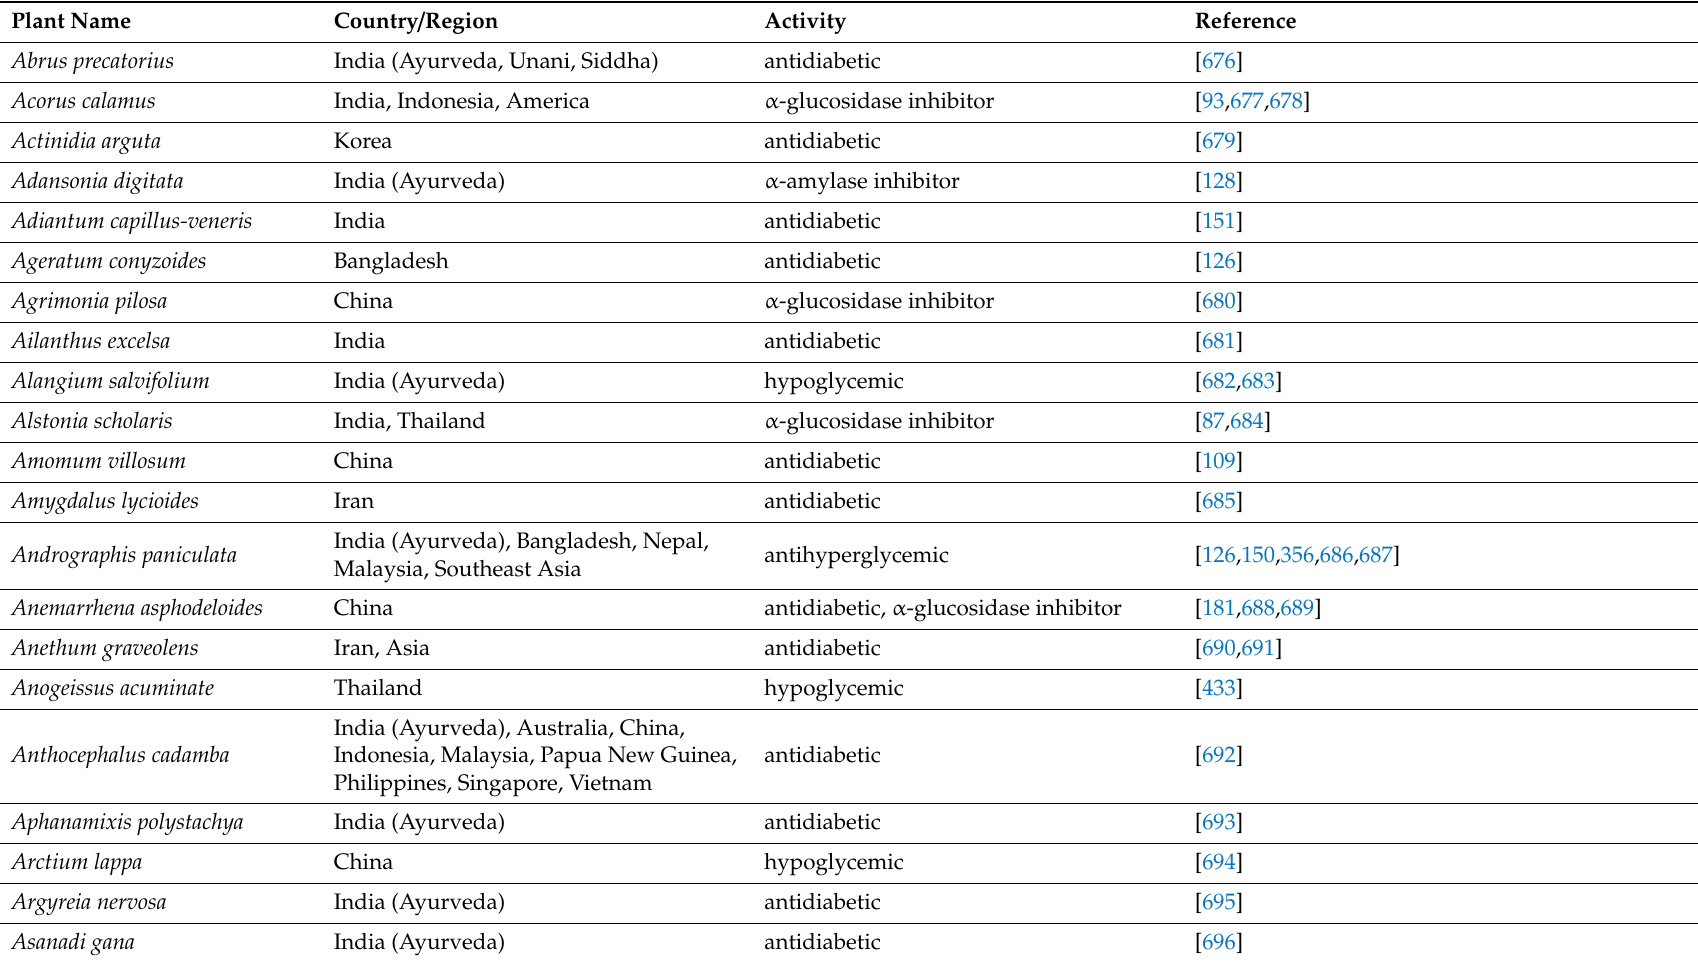
Table 2. Antidiabetic plants where only one species is